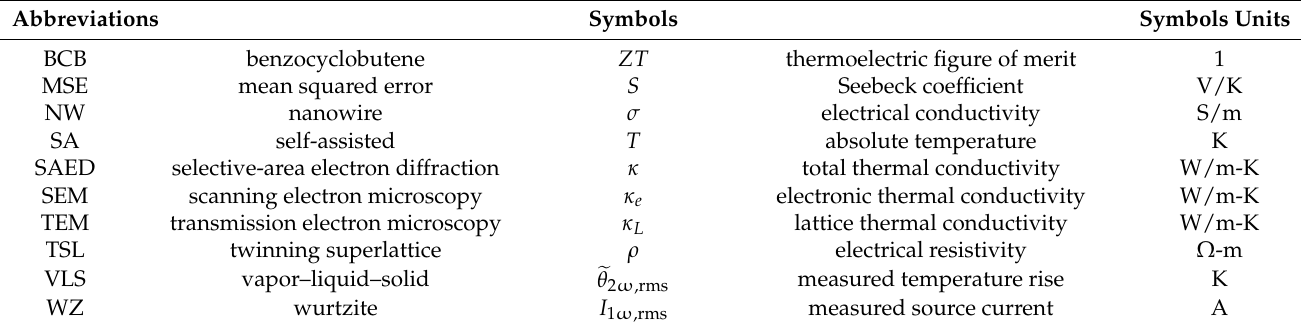
Table A6. Abbreviations and